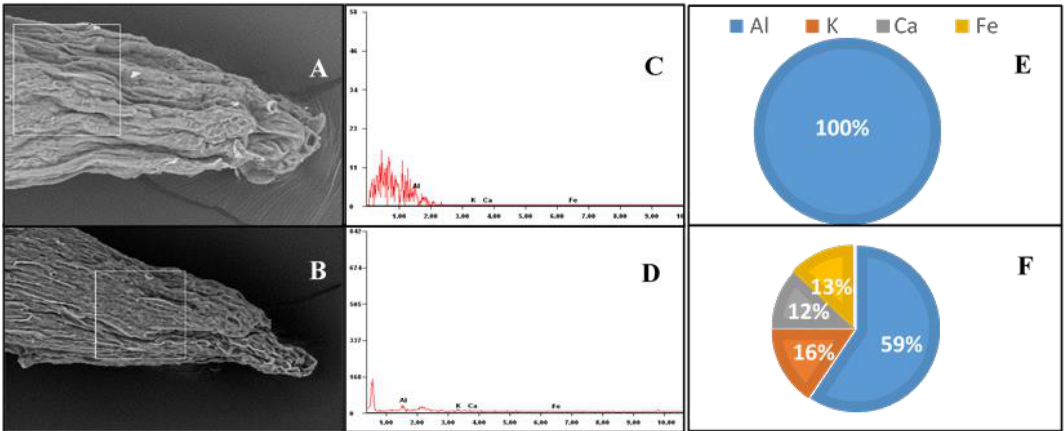
Figure 1. Scanning images, energy-spectrum analysis, and element percentage in the meristematic zone of two Lespedeza species . ( A , C , E ), L. bicolor ; ( B , D , F ), L. cuneata . Seedlings (five-day-old) of two Lespedeza species were subjected to 0.5 mM CaCl 2 solutions (pH 4.5) with 200 µM Al for 24 h. Scanning images ( A , B ) were observed by the scanning electron microscopy microscope. The image magnification was 750 under 20 kV voltage. All pictures were taken under the same conditions. Energy-spectrum analysis ( C , D ) was carried out using energy-dispersive X-ray spectroscopy, and element percentages ( E , F ) were obtained from the energy-spectrum analysis.